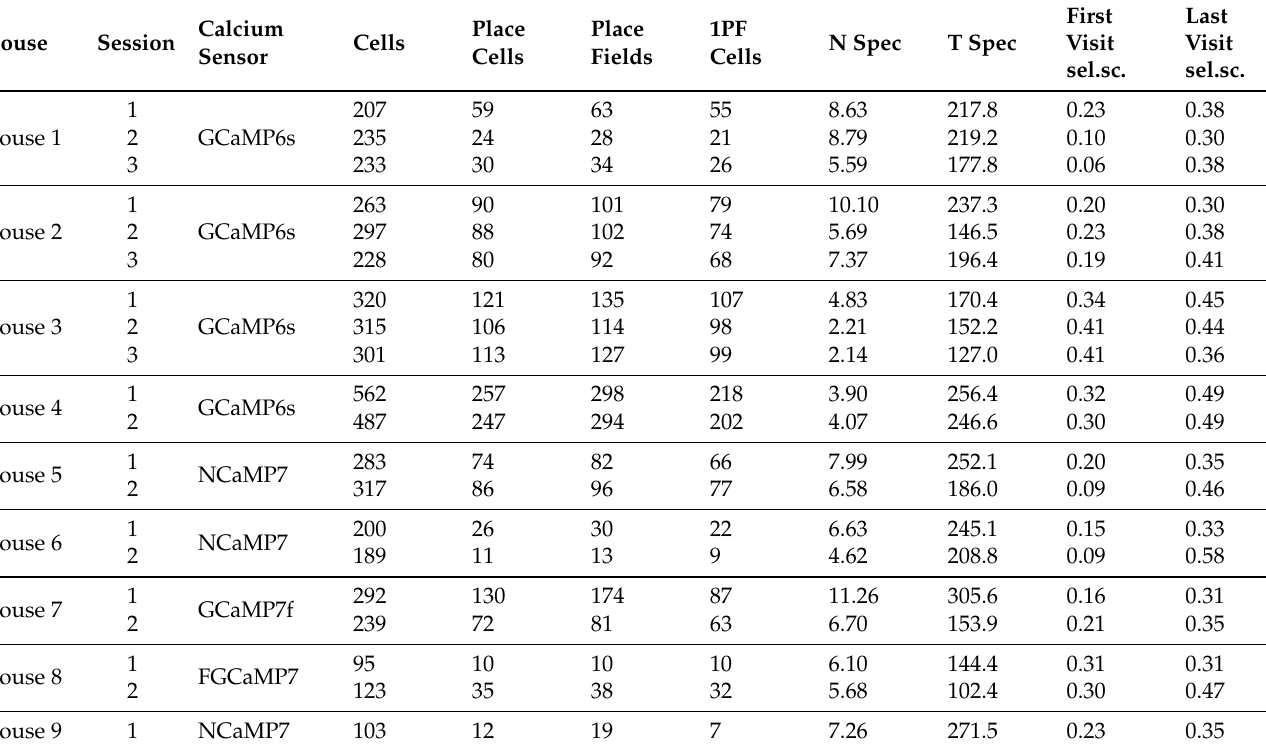
Table A1. Mousewise statistics for each registered session. 1PF Cells, single-field place cells. N spec and T spec, the average number of visit to a place field and correspondent time in seconds, since which this place field is considered tuned. First visit and Last visit sel.sc., the average values of selectivity score at the first and at the last attendance of a place field.